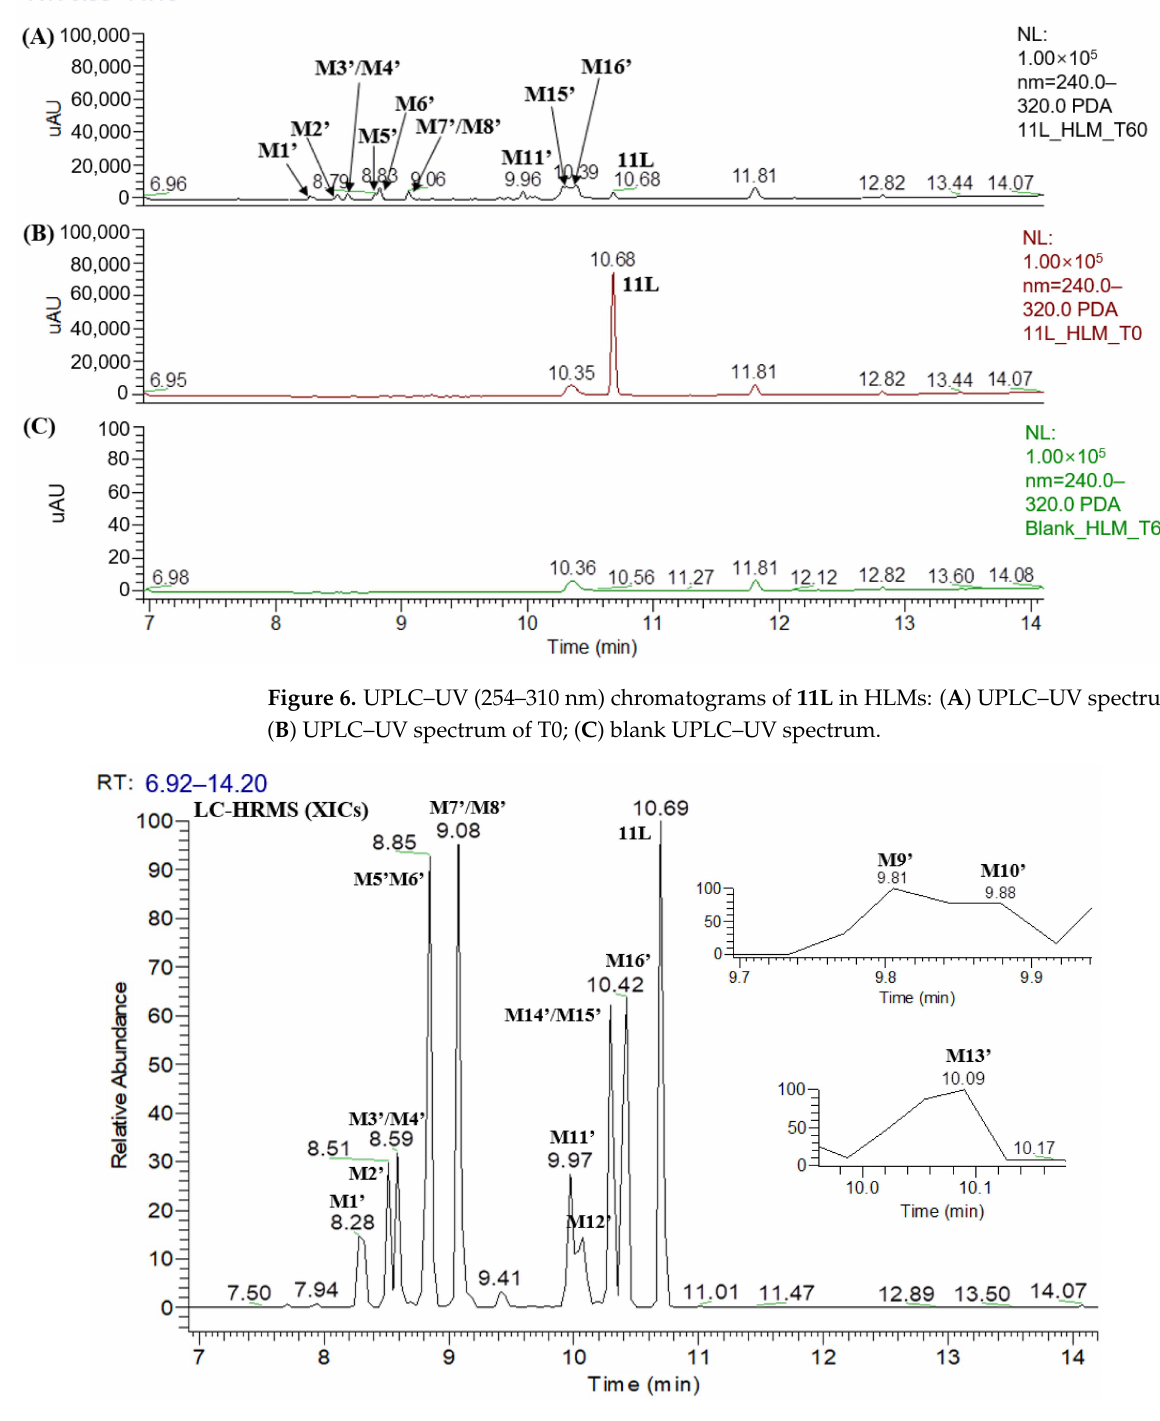
Figure 7. XIC of 11L in